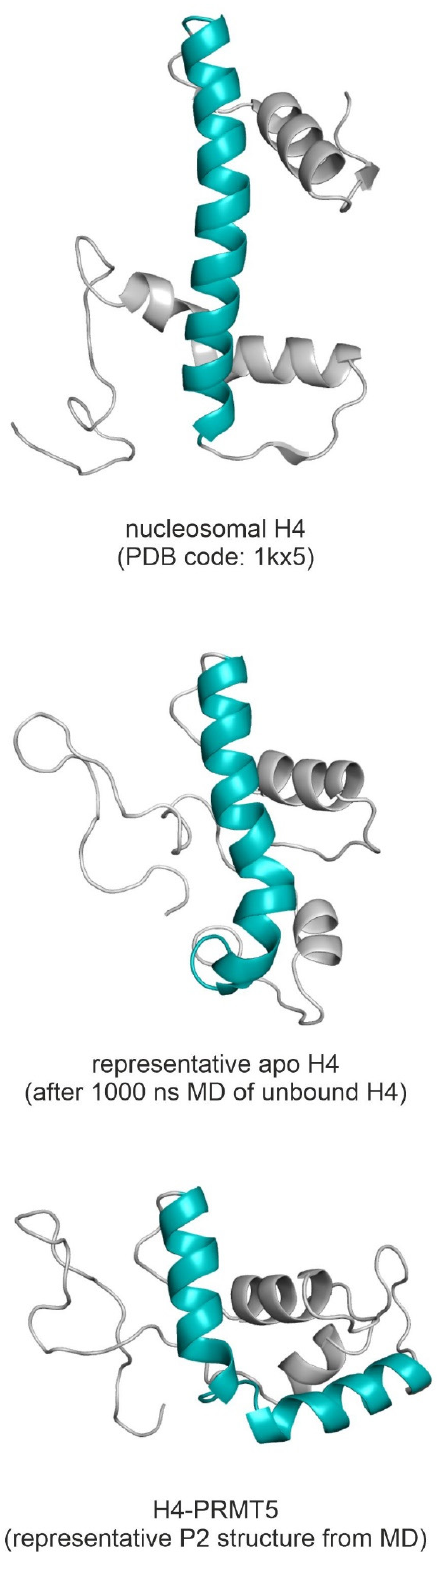
Figure 5. Histone H4 conformations (cartoon, grey) in the nucleosomal, unbound (apo) and PRMT5- complexed forms. Helix 3 (highlighted in teal) adopts a V-shaped conformation in the PRMT5-complexed structure, while it is mostly linear in the nucleosomal and apo forms.